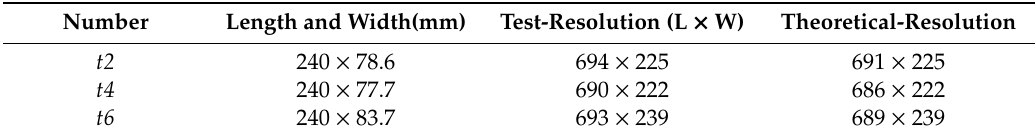
Table 3. The scanning resolution of surface contour detection